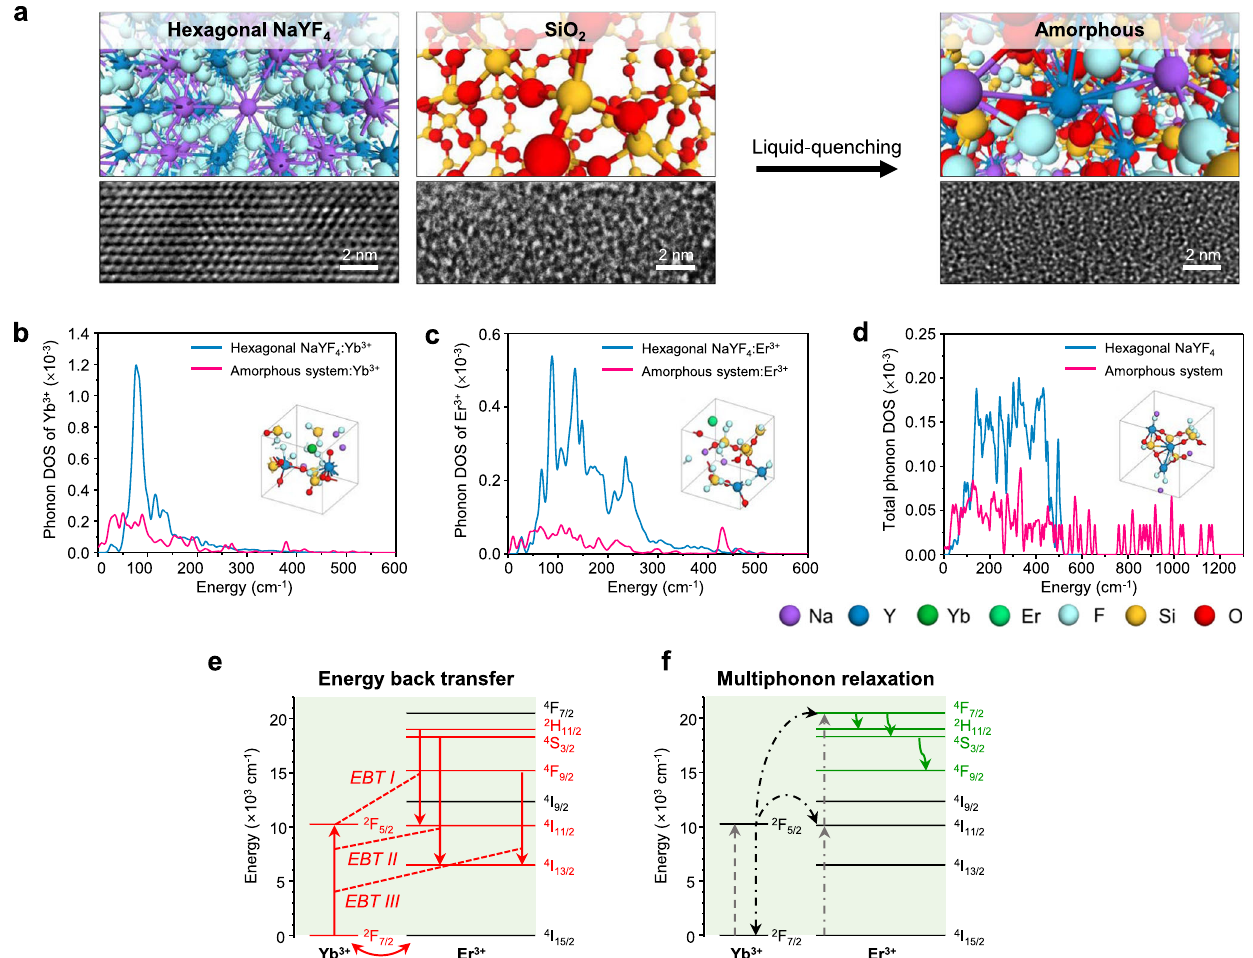
Fig. 3 Theoretical analysis of the enhancement of the upconversion lasing ef fi ciency in the amorphous phase of NaYF 4 combined with SiO 2 . a Schematic and TEM images of the microstructure of the amorphous phase after liquid quenching of hexagonal NaYF 4 with SiO 2 . b Phonon DOS of Yb 3 + in the Yb-doped amorphous system (Model 6 in Supplementary Fig. 12, which shows the largest difference from hexagonal crystal NaYF 4 ) and Yb-doped hexagonal crystal NaYF 4 (Supplementary Fig. 15b). c Phonon DOS of Er 3 + in the Er-doped amorphous system (Model 5 in Supplementary Fig. 13, which shows the largest difference from hexagonal crystal NaYF 4 ) and Er-doped hexagonal crystal NaYF 4 (Supplementary Fig. 15c). d Total phonon DOS of the amorphous system (Model 2 in Supplementary Fig. 11) and hexagonal crystal NaYF 4 (Supplementary Fig. 15a). Note that the total phonon DOS are normalized by dividing by the total number of atoms in each system. e , f Mechanisms of energy back transfer (Er 3 + → Yb 3 + ) ( e ) and multiphonon relaxation (Er 3 + ) ( f ). Δ E for energy back transfer: ~1373.4 cm − 1 for EBT I (between 2 F 7/2 → 2 F 5/2 (Yb 3 + ) and 2 H 11/2 → 4 I 11/2 (Er 3 + )), ~1553.1cm -1 for EBT II (between 2 F 7/2 → 2 F 5/2 (Yb 3 + ) and 4 S 3/2 → 4 I 13/2 (Er 3 + )) and ~1563.7 cm -1 for EBT III (between 2 F 7/2 → 2 F 5/2 (Yb 3 + ) and 4 F 9/2 → 4 I 13/2 (Er 3 + )). Δ E for multiphonon relaxation of the Er 3 + ion: 4 F 7/2 → 2 H 11/2 = ~1483 cm − 1 , 4 F 7/2 → 4 S 3/2 : ~2195 cm − 1 , and 4 S 3/2 → 4 F 9/2 = ~3117 cm − 1 . Note that red solid arrows with red dashed lines indicate energy transfers by EBT. Red curved arrows indicate an interaction between Yb 3 + and Er 3 + . Gray dashed, black dot- dashed, and green solid arrows indicate absorption, energy transfer, and multiphonon relaxation,